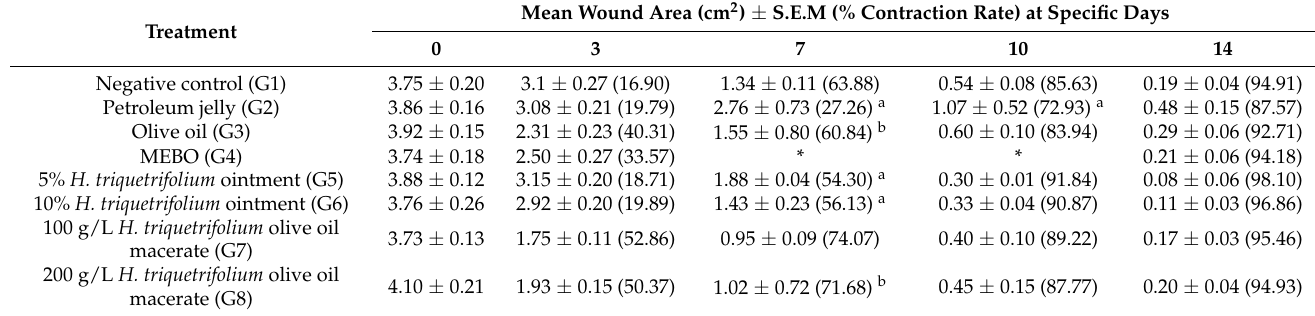
Table 1. Effects of the investigated formulations on excision wound model.